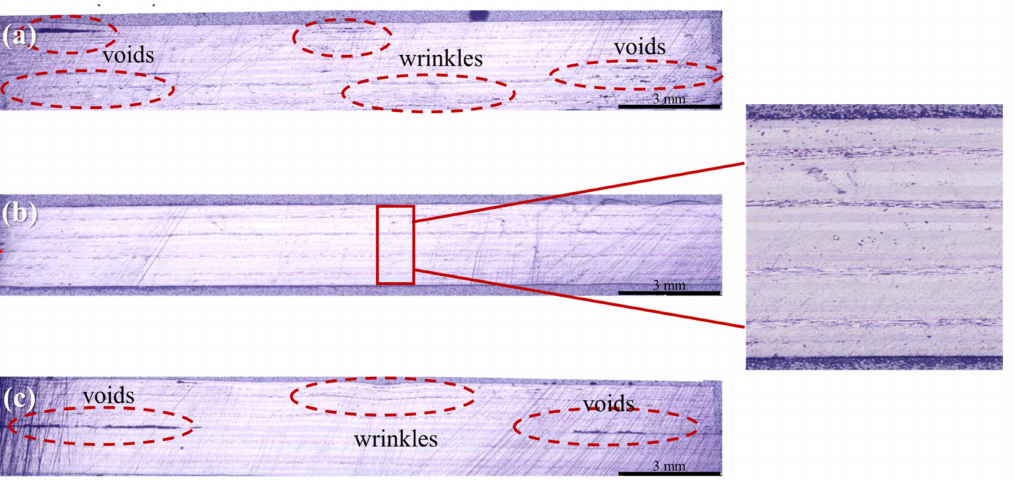
Figure 5. Cross-sectional optical micrographs of the CF/PPS composites; samples obtained at processing temperatures of ( a ) 250 ◦ C, ( b ) 280 ◦ C, and ( c ) 310 ◦ C via induction